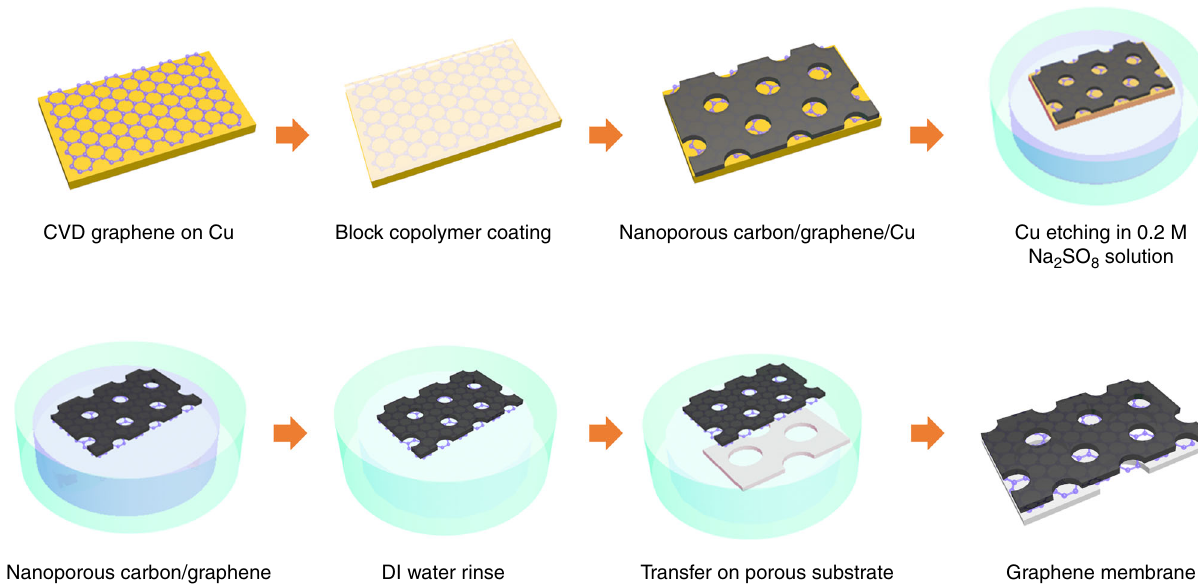
Fig. 1 Schematic of fabrication of large-area graphene membrane by the nanoporous carbon (NPC) fi lm-assisted transfer method. A block-copolymer solution was spin-coated onto the CVD graphene supported on the Cu foil; pyrolysis was conducted to form NPC fi lm on top of graphene. The copper was etched by 0.2 M sodium persulfate, after which the fl oating graphene/NPC fi lm was rinsed with DI water. Finally, the NPC/graphene fi lm was transferred onto the porous tungsten